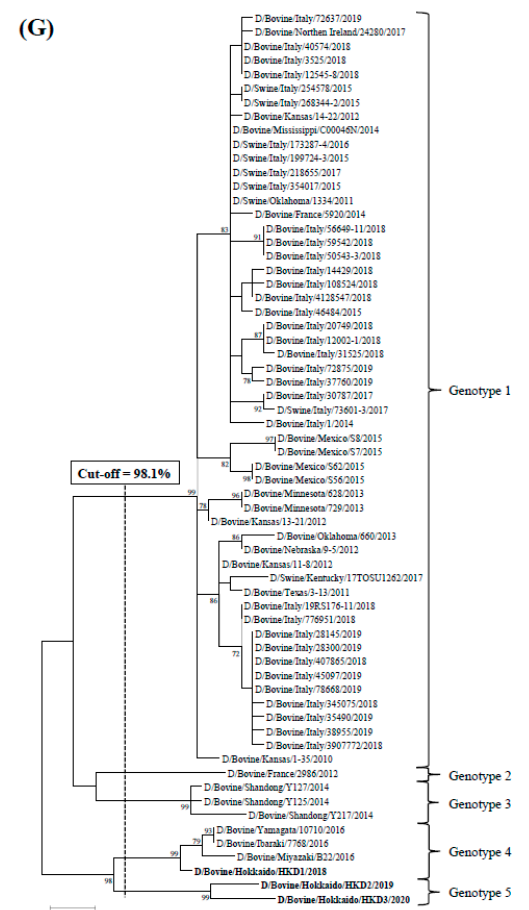
Figure 1. Phylogenetic analyses of the seven RNA segments of influenza D viruses detected in this study and previous studies. ( A ) Polymerase basic protein 2; ( B ) Polymerase basic protein 1; ( C ) Polymerase protein 3; ( D ) Hemagglutinin-esterase-fusion protein; ( E ) Nucleoprotein; ( F ) Matrix protein; ( G ) Nonstructural protein. Trees were constructed using the maximum-likelihood method in the MEGA X program. Numbers at the branch represent groups with >70% bootstrap support using 1000 replicates. Bold text represents the three bovine influenza D viruses isolated in this study. The scale bar indicates nucleotide substitutions per site.